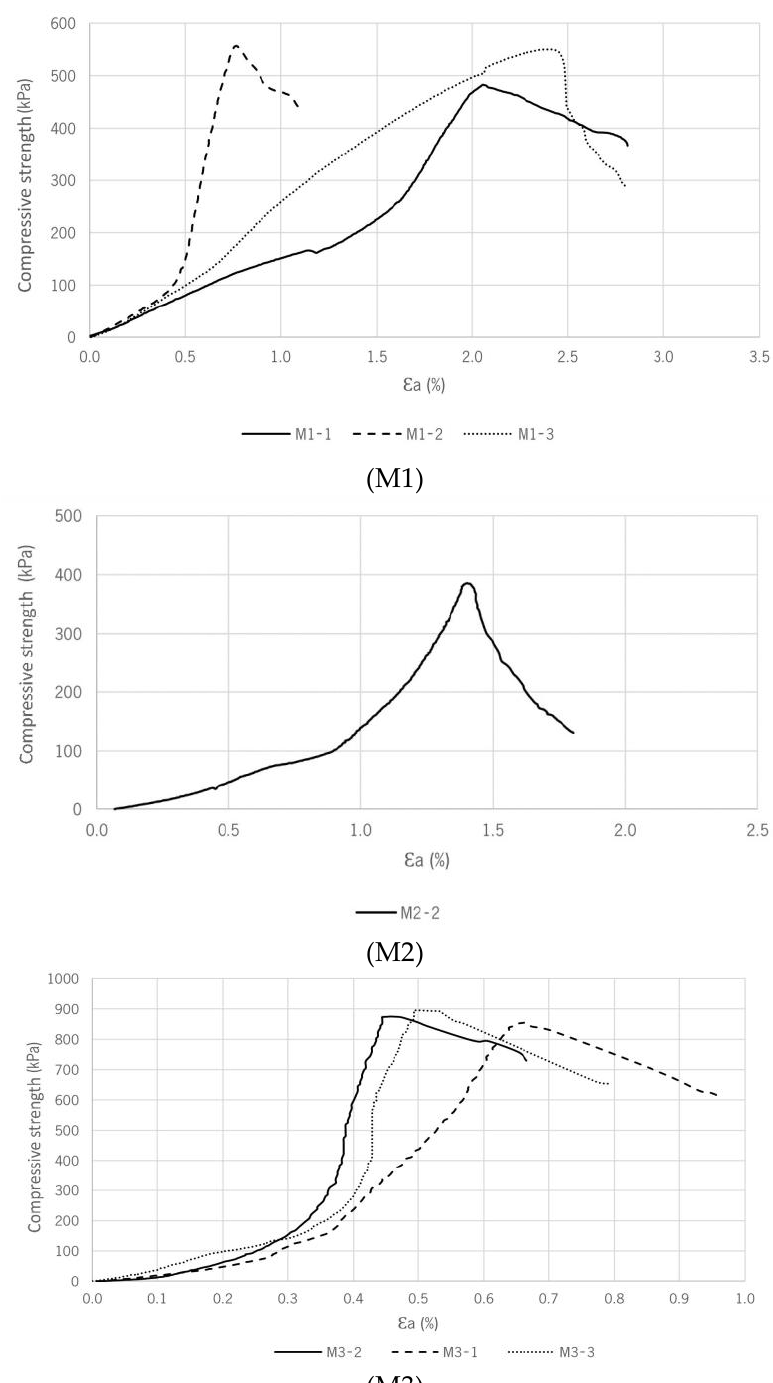
Figure 15. Evolution of compressive strength vs. axial strain for mixtures M1, M2 and M3.